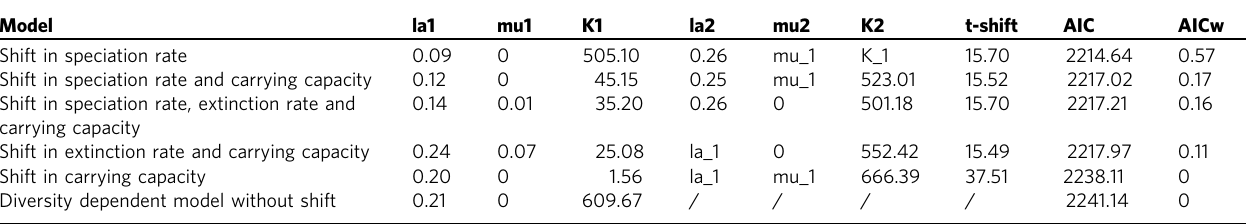
Table 1 Comparison of evolutionary models tested in order to identify the diversi fi cation pattern and rate shifts in the phylogeny of Niphargus